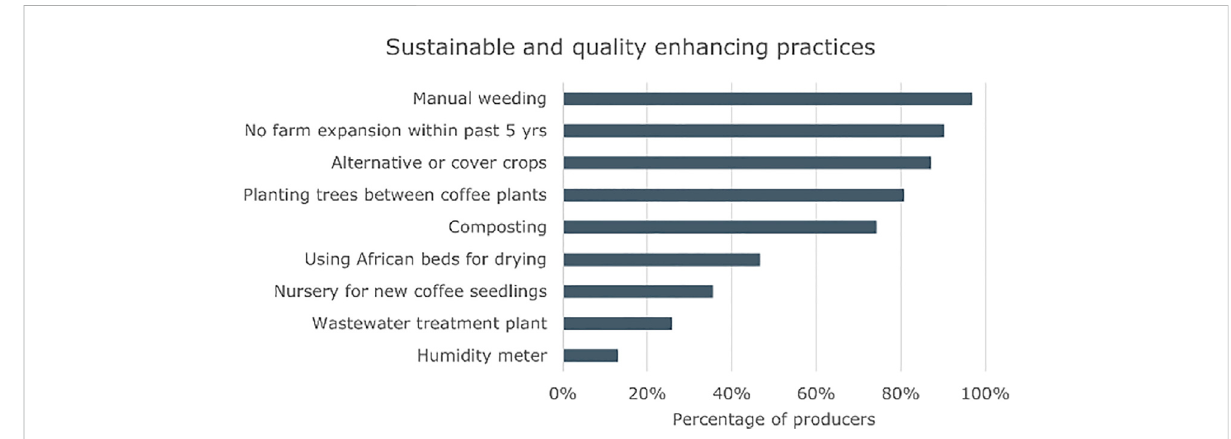
Sustainability and quality enhancing practices. The majority of interviewees conduct manual weeding, did not clear forests for additional croplandandplanalternativeorcovercrops,aswellastreesbetweencoffeeplants.Compostingisalsoawidespreadpractice.A “ humiditymeter ” isa portable measuring instrument for thedetermination oftheabsolute water contentofcoffeebeans. An “ African (drying/raised) bed ” is awood frame stretcherwithasuspendednettingholdingthebeansabovethegroundtoallowaircirculationaboveandbelowthebeans,oftencoveredwitha